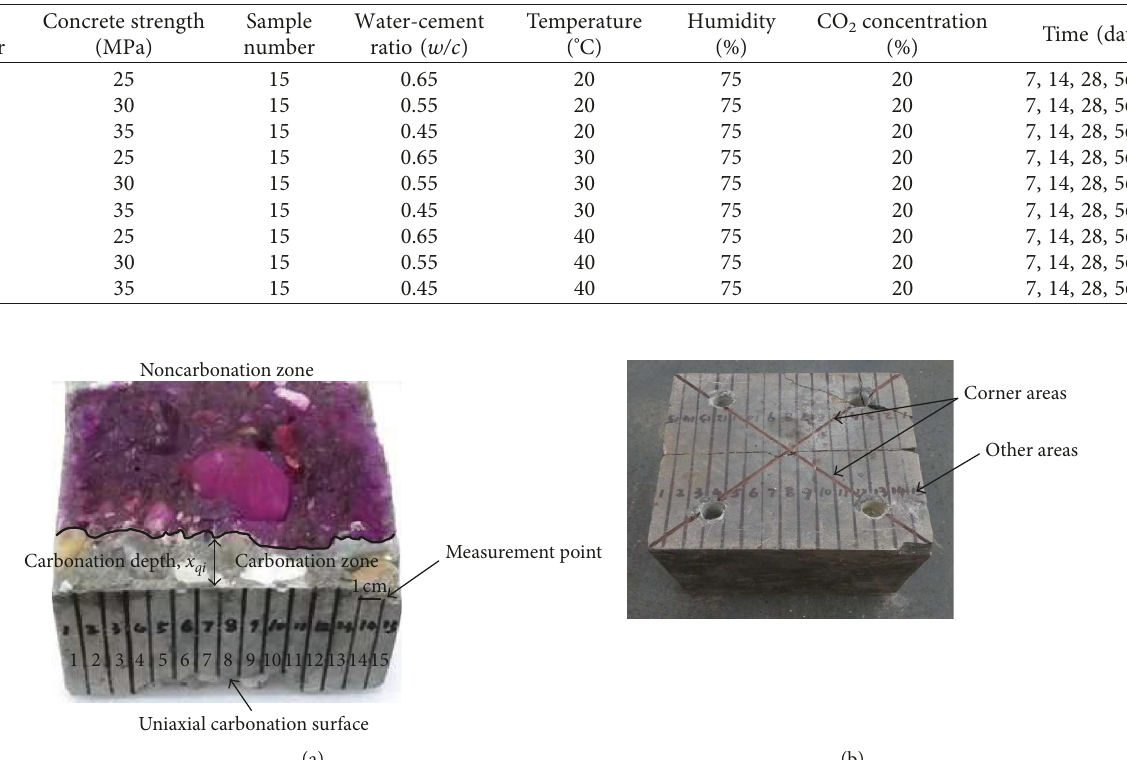
Figure 8: Tested block in the carbonation chamber. Table 2: Detailed setting of each parameter for each group.